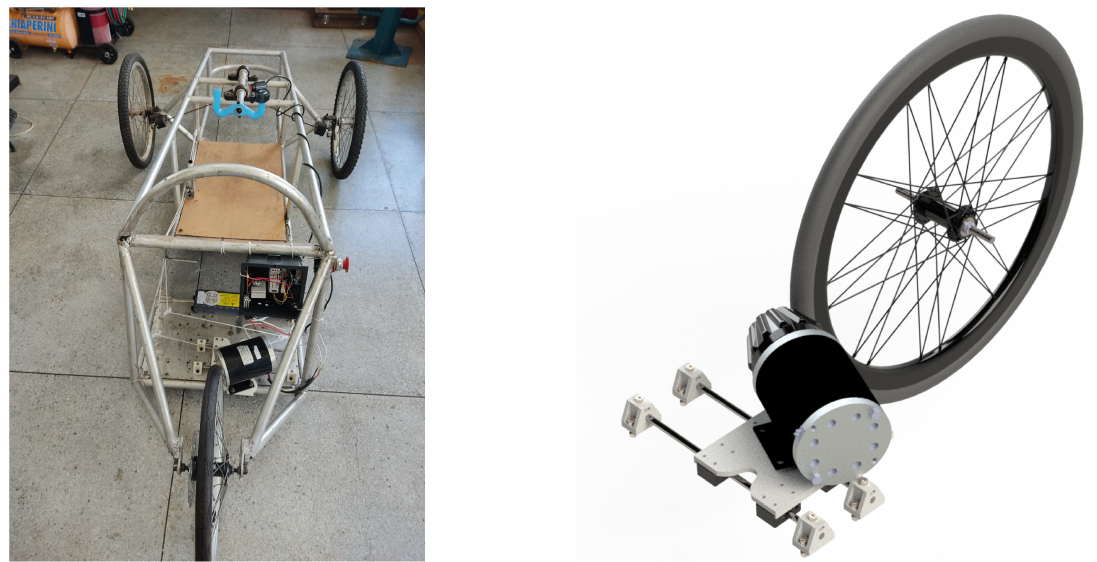
Figure 3. EV prototype ( left ) and virtual representation of the idealized CVT concept ( right